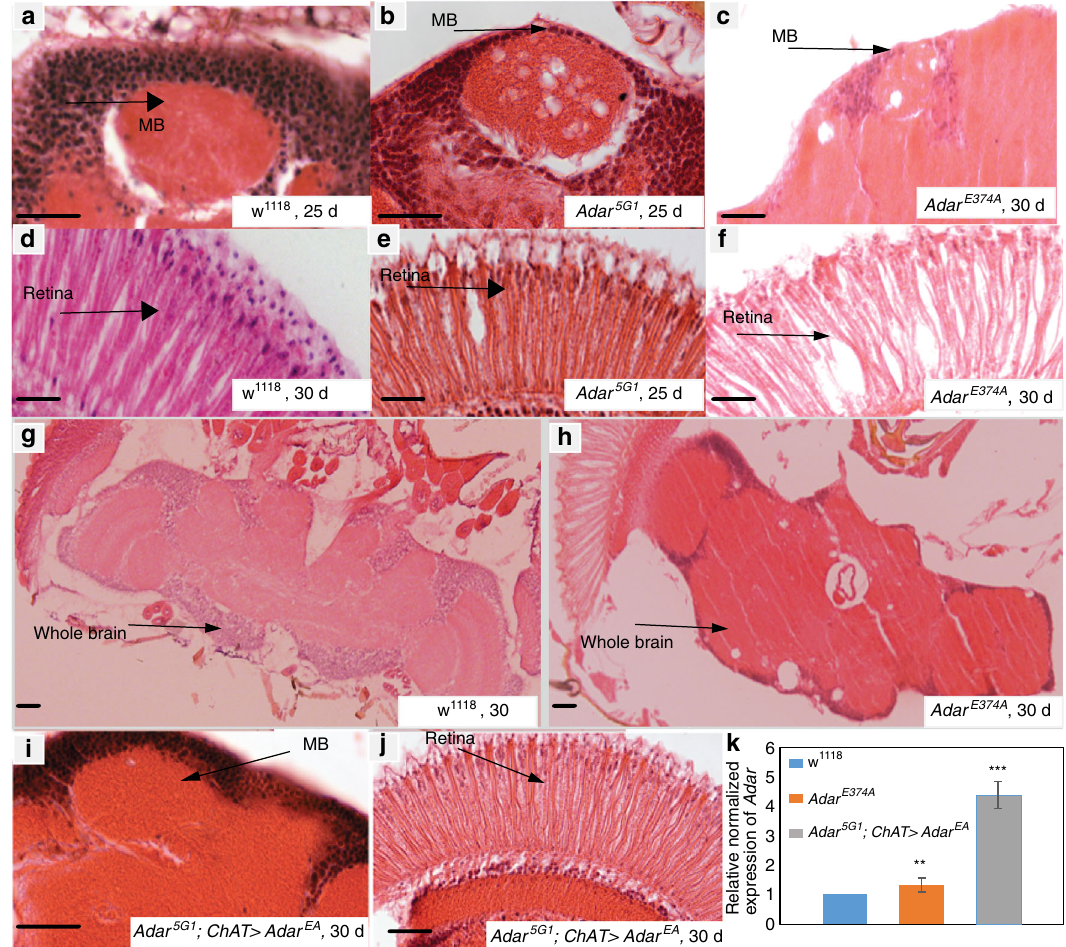
Fig. 3 Neurodegeneration in the Adar E374A mutant is similar to the Adar 5G1 null mutant. a – j Neurodegeneration in haematoxylin-eosin stained 5 micron paraf fi n wax sections of mushroom body in ( a ) wild-type w 1118 day 25, ( b ) Adar 5G1 at day 25 ( c ) Adar E374A at day 30. Staining of retina in ( d ) wild-type w 1118 day 30 ( e ) Adar 5G1 at day 25 ( f ) Adar E374A at day 30. Staining of whole brain ( g ) wild-type w 1118 day 30 ( h ) Adar E374A at day 30. ( i ) ChAT-GAL4 -driven Adar E374A expression in cholinergic neurons is suf fi cient to prevent neurodegeneration in Adar 5G1 mutant mushroom body at day 30 and ( j ) retina day 30. Scale bars: 20 μ m. k Adar transcript expression in fl y heads is greater in Adar 5G1 ; ChAT > Adar E374A fl ies expressing Adar from a UAS-Adar E374A construct in cholinergic neurons than it is in wild type w 1118 or Adar E374A chromosomal mutant fl ies. p -value was calculated by Student ’ s t test *: p -value < 0.05. **: p -value < 0.01. ***: p -value < 0.005: n.s — not signi fi cant. Error bars: SEM (Standard Error of Mean for biological